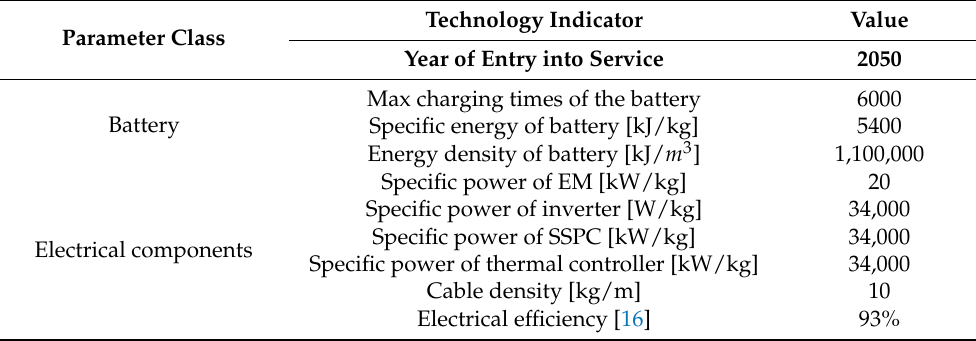
Table 3. Specifications of the estimated